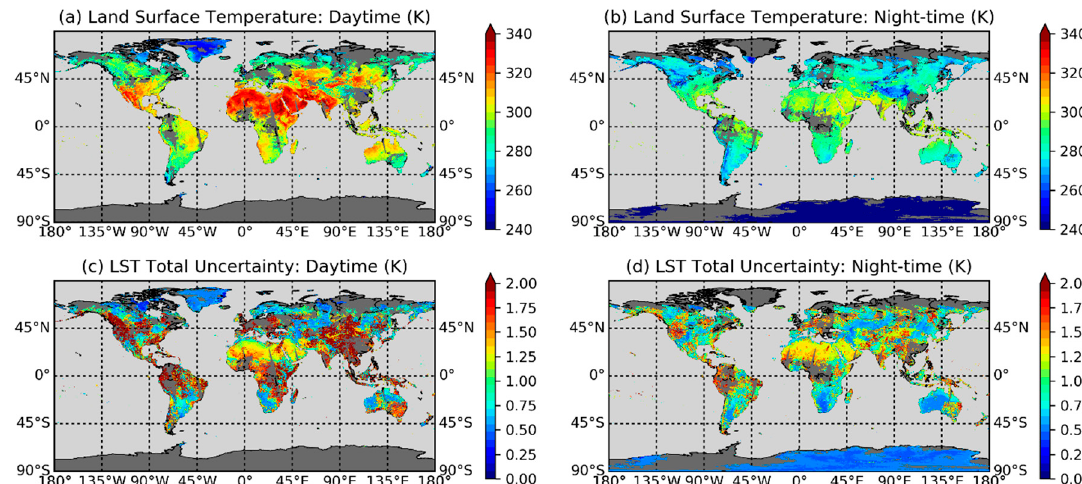
Figure 6. Aqua MODIS global Level-3 gridded LST data and associated total uncertainty estimates for 1 June 2010: ( a ) daytime LST composite; ( b ) nighttime LST composite; ( c ) total uncertainty for the daytime LST composite; and ( d ) nighttime LST composite.